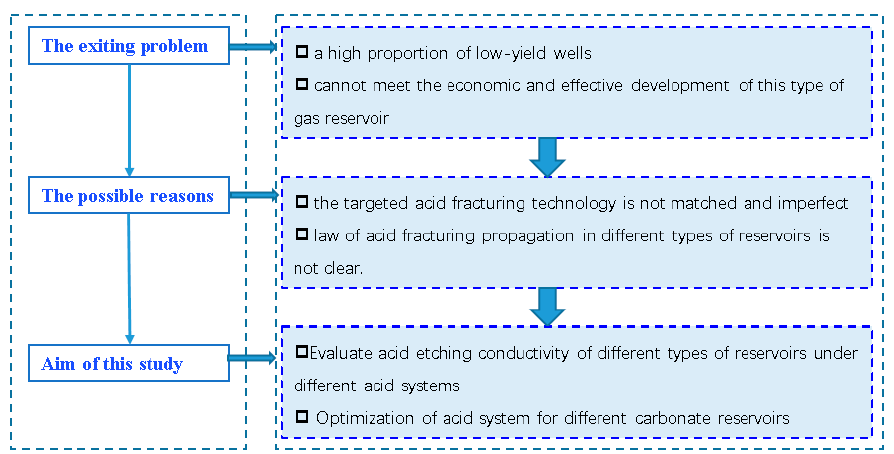
Figure 1. The general sketch of the problem under study.